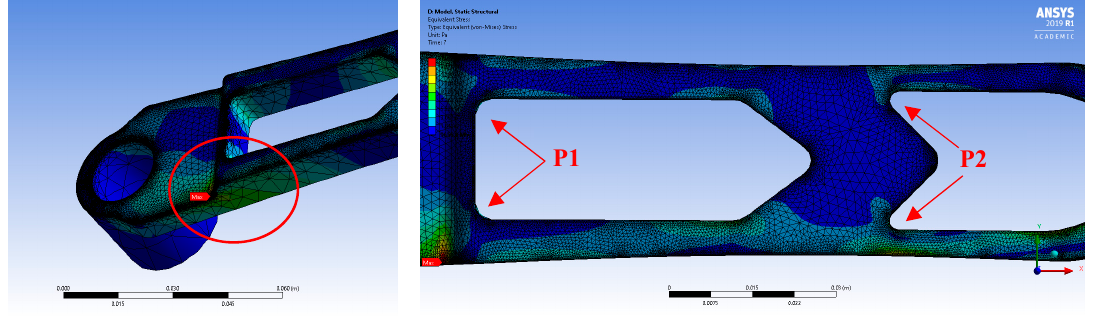
Figure 15 . Two topological radius P1 and P2 as the response surface optimization variables.